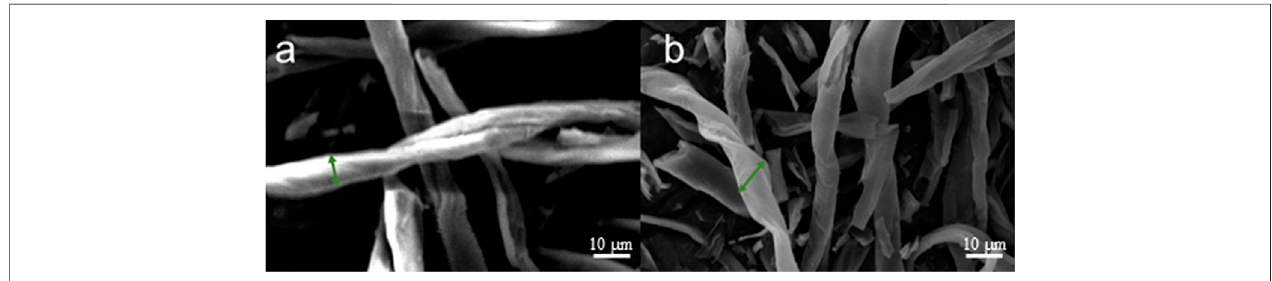
FIGURE 4 | (A) SEM image of cotton heated and carbonized by a fl at plate at 400 ° C and (B) SEM image of cotton pyrolyzed in a tube furnace at 400 ° C.